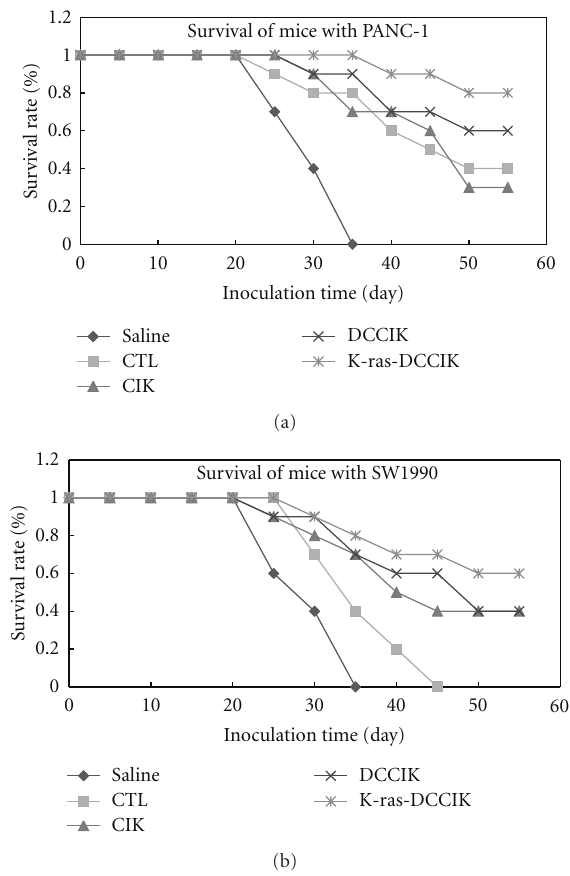
Figure 8: Survival of nude mice inoculated subcutaneously in the back with PANC-1 (K-ras + ) and SW1990(K-ras − ) cells after immunotherapy with CTLs and di ff erent CIKs (experiment 2.8) concerning the e ff ects on the survival time of PANC-1 (K-ras + ) tumor-bearing mice (Figure 8(a)), the survival time of group K-ras- DCCIK was prolonged remarkably, compared with other groups ( P < 0 . 01). No statistical di ff erence was found among the group DCCIK, CIK and CTL ( P > 0 . 05). It is demonstrated that the k-ras-DC induced CTL can inhibit PANC-1. Meanwhile, K-ras- DCCIK can produce specific and immediate killing e ff ect on PANC- 1. Concerning the e ff ects on the survival time of SW1900 (K-ras − ) tumor-bearing mice (Figure 8(b)), the survival time of group K-ras- DCCIK, DCCIK and CIK was elongated dramatically. Compared with group CTL ( P < 0 . 01). The CIK groups possess the direct inhibition to SW1900. The CTL induced by K-ras-DC showed the lower inhibition to K-ras mutation negative cell, SW1900. Thus, the survival time of the SW1900 tumor-bearing mice was not